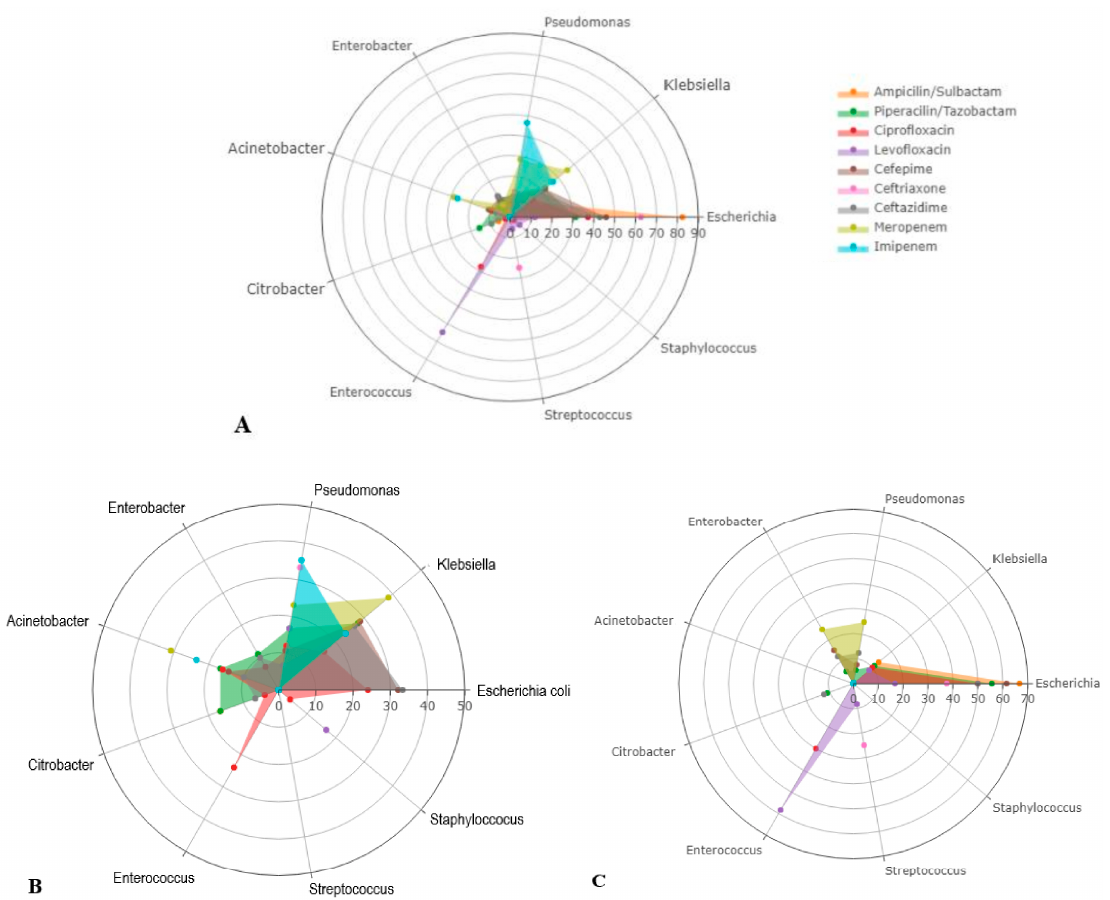
Figure 1. Radar plots reporting resistance microbial sensitivity of given antibiotics for patients with acute cholangitis. All patients ( A ), malignant ( B ), benign ( C ). Figures generated with Plotly data analytics and visualization tools.